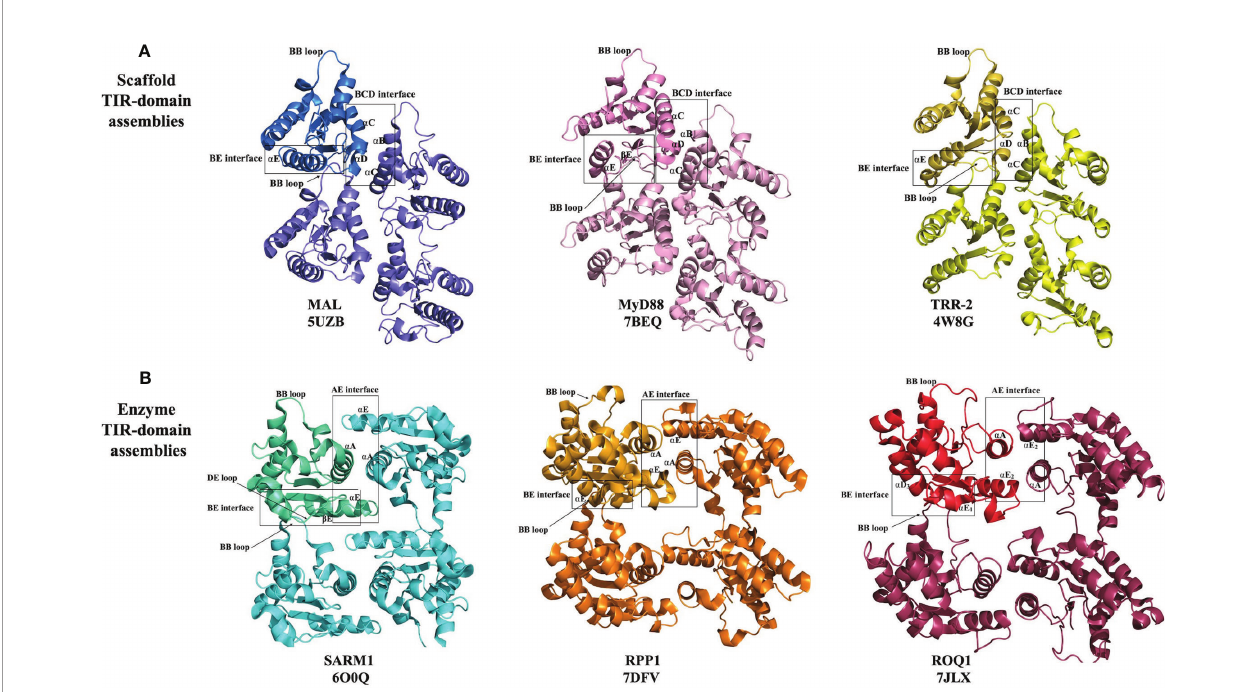
FIGURE 3 | Structural basis of eukaryotic TIR-domain assembly formation. (A) Scaffold TIR-domain assemblies, held together by the BE and BCD interfaces, represented by the TIR domains from MAL, MyD88 and TRR-2. (B) Enzyme TIR-domain assemblies held together by the BE and AE interfaces, represented by the TIR domains from SARM1, RPP1 and